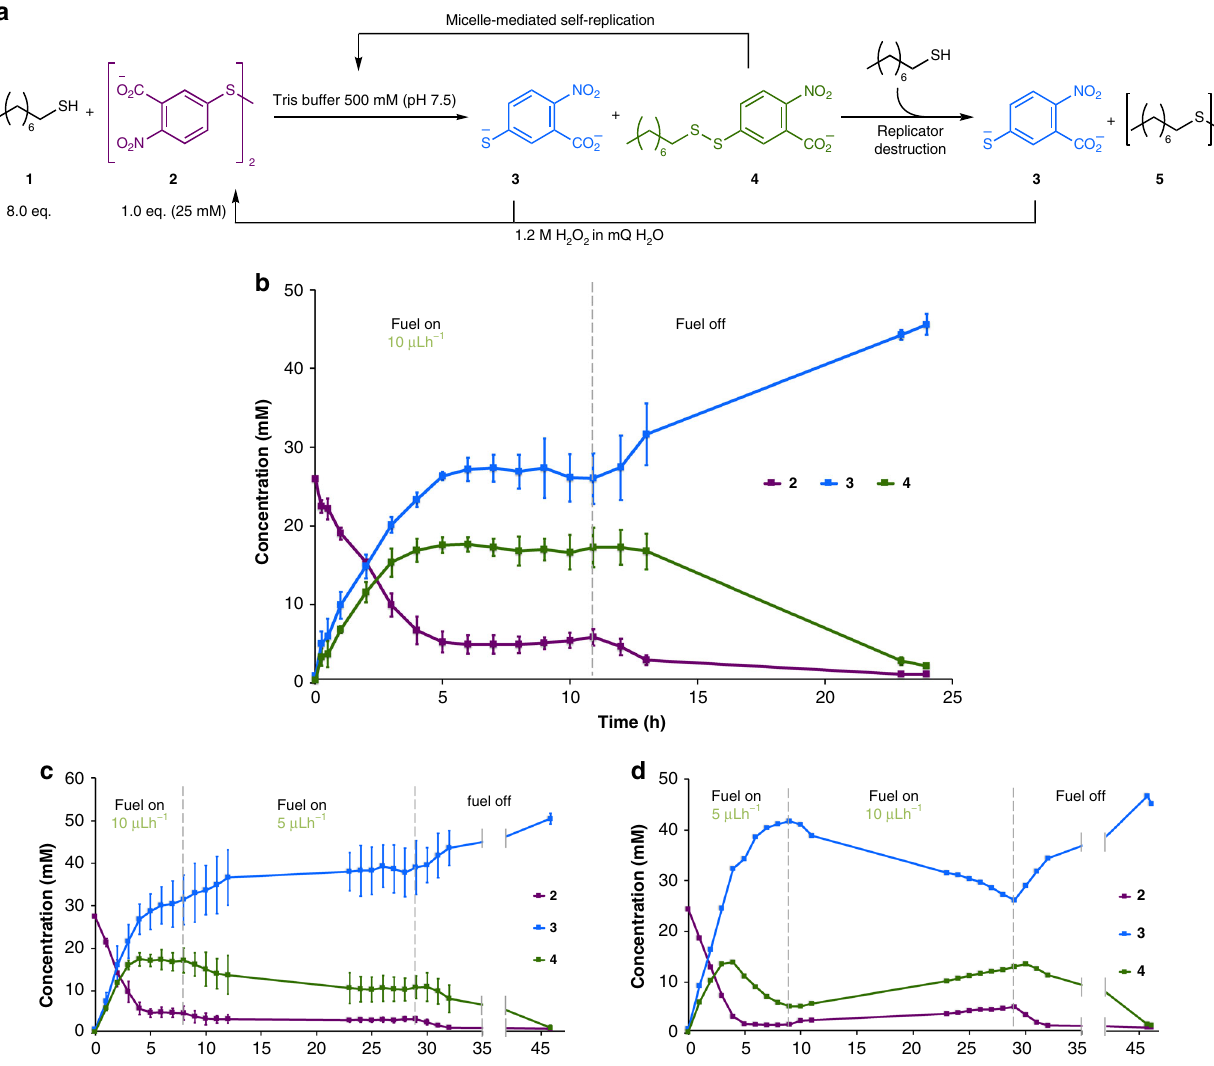
Fig. 5 Self-replication maintained out-of-equilibrium by addition of a chemical fuel: a Chemical structures and reactions involved in the out-of-equilibrium system. b Continuous supply of an oxidising fuel to the aqueous phase (by syringe pump) completes the substrate cycle and allows 4 to reach a steady state. By the chemically fuelled continuous regeneration of 2 the rates of formation and destruction of surfactant 4 can be balanced so that while individual molecules are continuously formed and destroyed the overall concentration remains steady. Once fuel supply is halted, the entire system degrades towards equilibrium with the destruction of 4 by excess 1 and the formation of waste products 3 and 5 . c Initial rate of oxidant supplied was 10 μ L h − 1 for 8 h, then 5 μ L h − 1 for 21 h. Lowering the rate of fuel supply causes the system to adapt to a new steady state with a lower concentration. Less fuel effectively limits the starting materials for the autocatalytic reactions; less 2 is available and 4 can no longer maintain as high a concentration. Once the fuel supply is halted, the entire system degrades towards equilibrium. d After an initial rate of fuel supply of 5 μ L h − 1 for 9 h, the rate was raised to 10 μ L h − 1 for a further 20 h. Increasing fuel supply allows the system to support higher replicator concentrations and maintain a position further removed from equilibrium. The concentration of reaction components was monitored by UPLC. Each plotted point in b , c is the average of three reactions and in d of two reactions. Error bars represent the standard